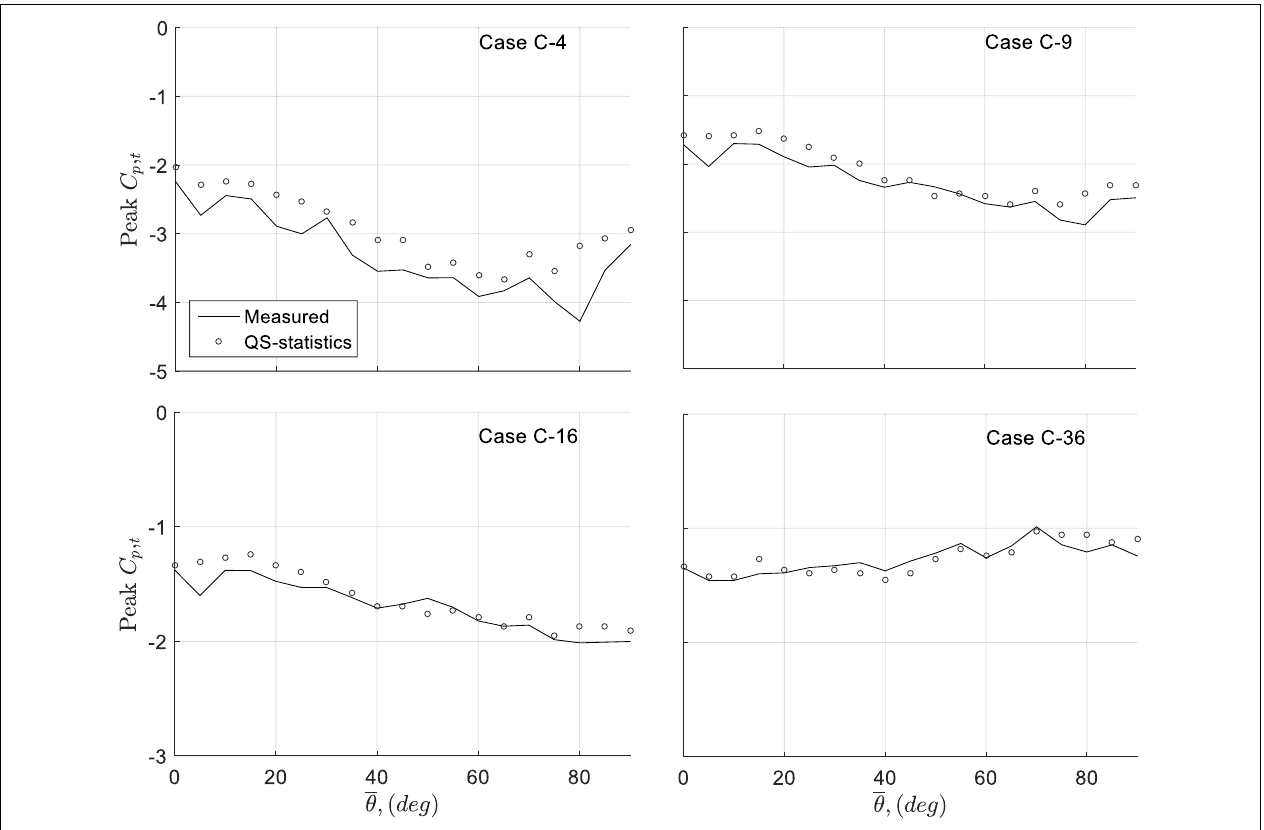
FIGURE 14 | Probability of QS- θθθ - βββ predicted pressures below (cid:0) 2 kpa for cases C-4, C-9, C-16, and C-36 for mean wind azimuth (cid:22) θ =(cid:22) θ =(cid:22) θ = 75° .